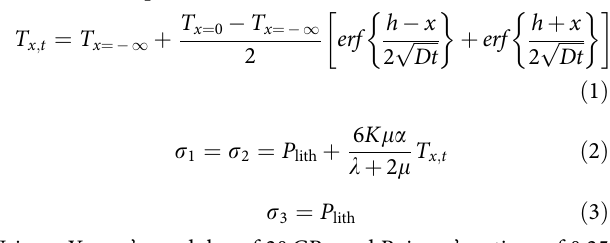
Using a Young’s modulus of 20 GPa and Poisson’s ratio m of 0.25 (ref. 50), the bulk modulus K is 1.33 (cid:3) 10 10 Pa. With thermal expansivity of 1 (cid:3) 10 (cid:2) 5 K (cid:2) 1 (ref. 51), we find that after 1 Ka the NATURE COMMUNICATIONS|7:13385|DOI: